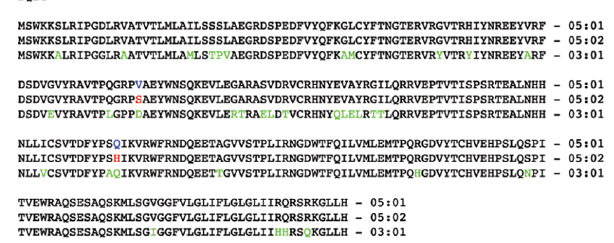
Fig 2. Amino acid sequence alignment of various HLA-DQB1